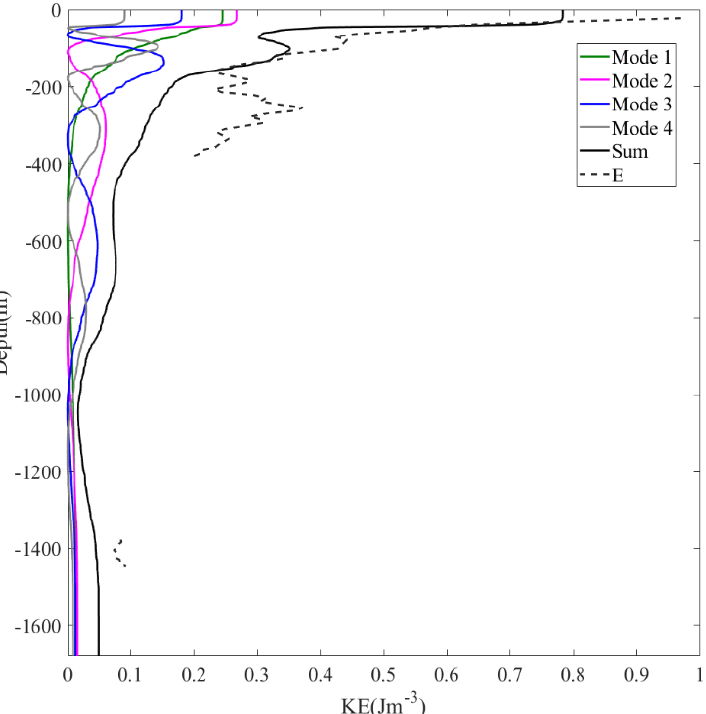
Figure 10. Vertical structures of the time-averaged NIKE for the first four modes (mode-1: green line; mode-2: magenta line; mode-3: blue line; mode-4: grey line), the sum of the four modes (black line), and the time-averaged NIKE calculated from the undecomposed near-inertial currents (black dotted line).